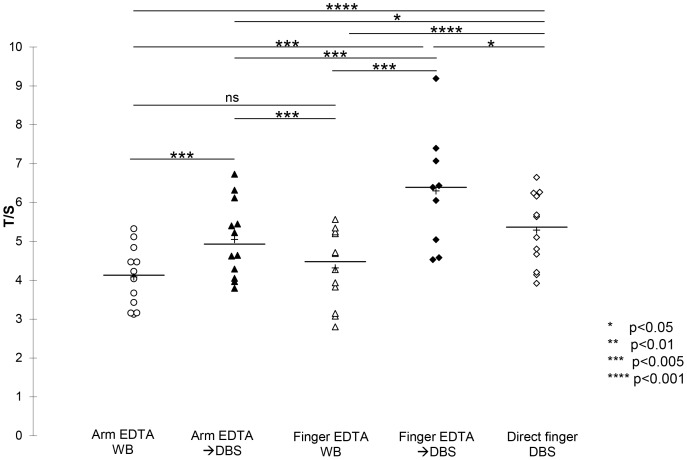
The effect of site of blood draw on T/S ratio measurements.T/S ratios were measured for DNA from arm EDTA whole blood, arm whole bloodDBS, finger EDTA WB, finger EDTADBS and direct finger prick blood made from a single blood draw from 12 distinct individuals. P values are shown, without adjustment for multiple comparisons. ns  =  not significant (p>0.05). The line represents the median and the + represents mean.